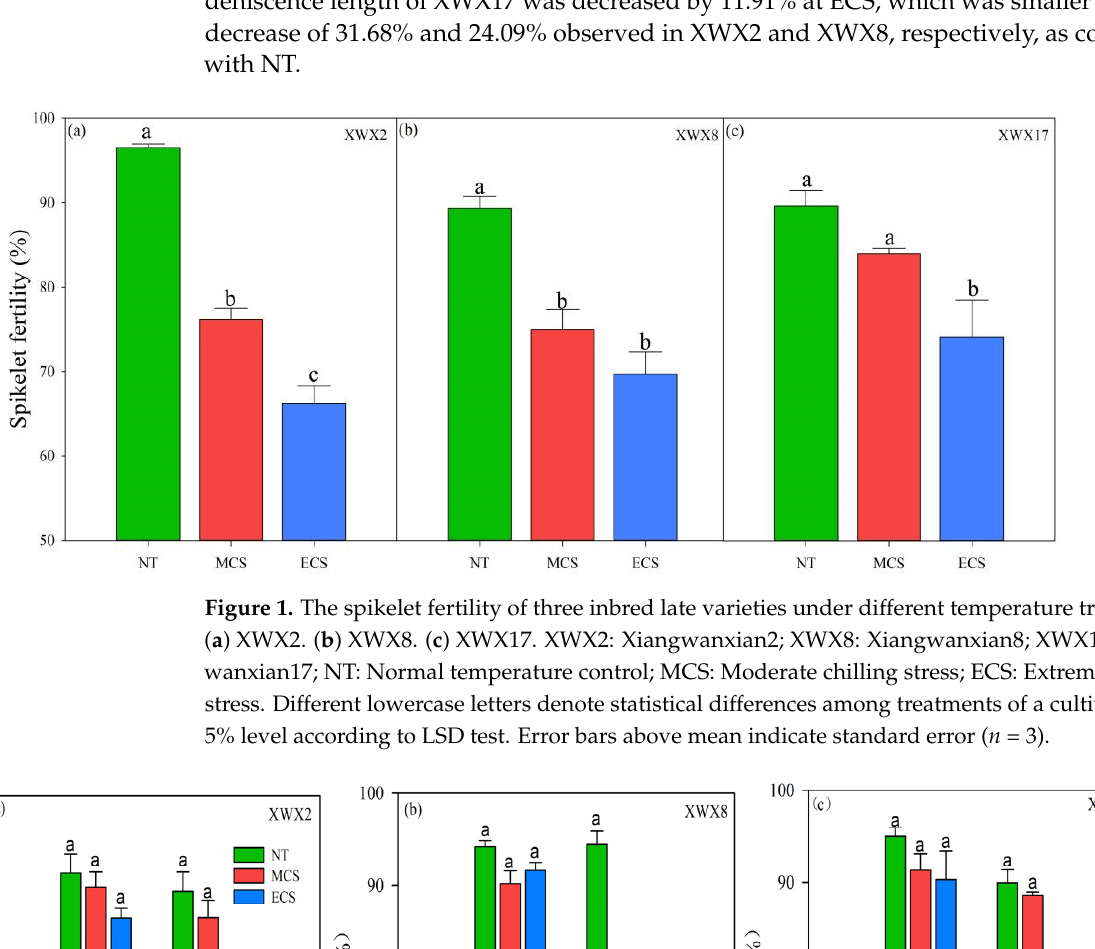
Figure 1. The spikelet fertility of three inbred late varieties under different temperature treatments. ( a ) XWX2. ( b ) XWX8. ( c ) XWX17. XWX2: Xiangwanxian2; XWX8: Xiangwanxian8; XWX17: Xiangwanxian17; NT: Normal temperature control; MCS: Moderate chilling stress; ECS: Extreme chilling stress. Different lowercase letters denote statistical differences among treatments of a culti- var at the 5% level according to LSD test. Error bars above mean indicate standard error ( n = 3).